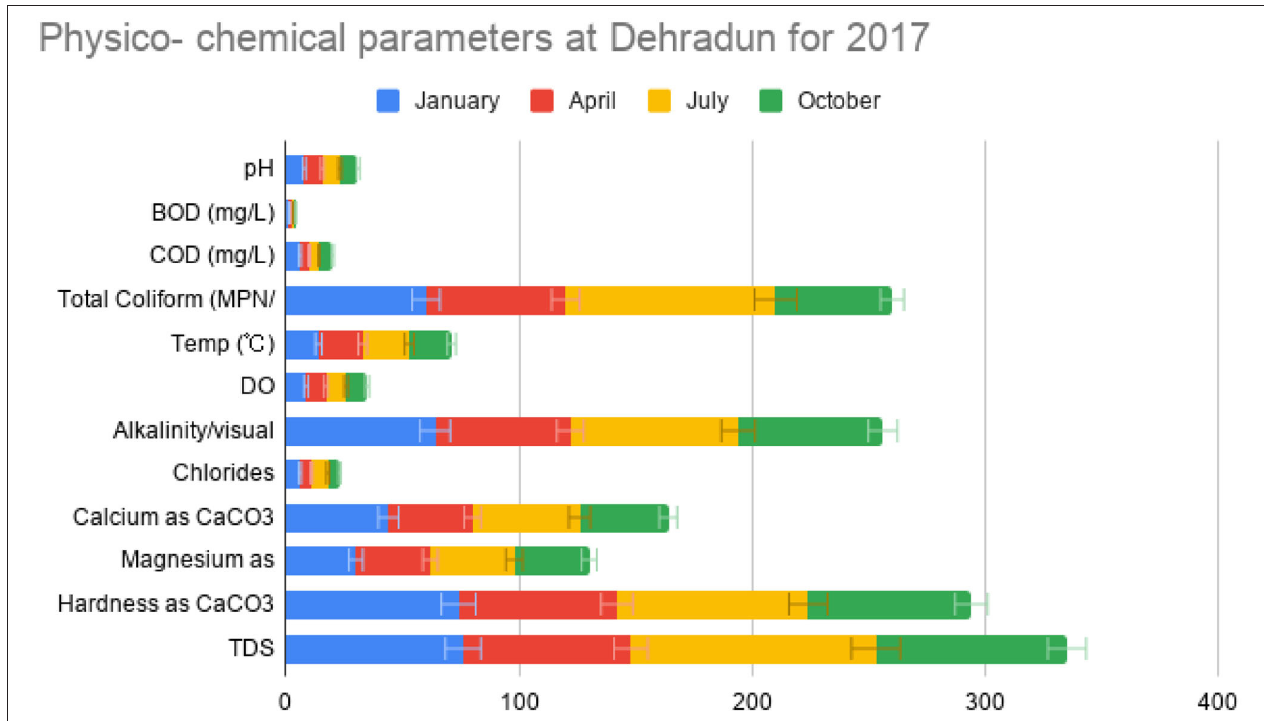
FIGURE 4 | Graphical representation of physicochemical parameters at Dehradun for 2017.